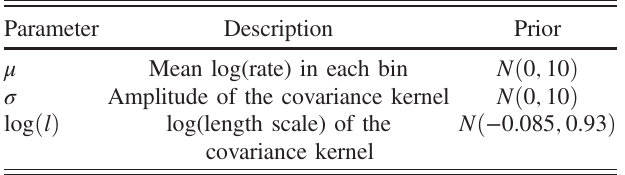
TABLE IX. Summary of B INNED G AUSSIAN PROCESS model